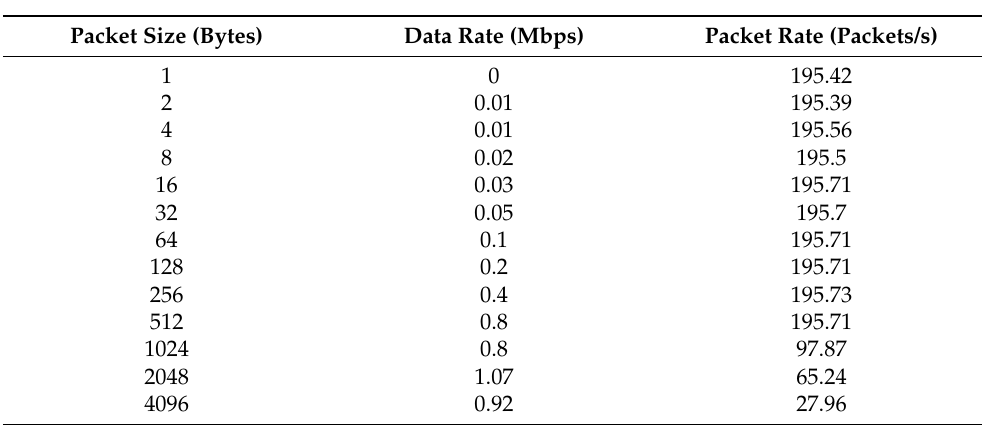
Table 4. WIC UWB GW (CDHU) to WIC UWB node (PDHU) maximum data rate.